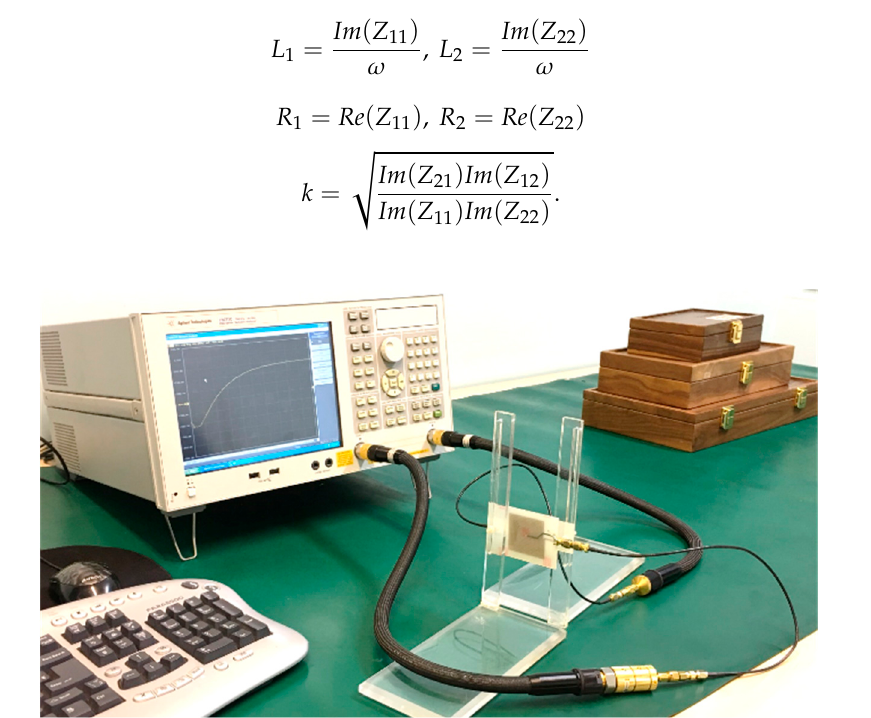
Figure 7. Experimental setup for measuring the S-parameters between a pair of printed spiral coils using a network analyzer. Table 4. Measured coils’ electrical specification.